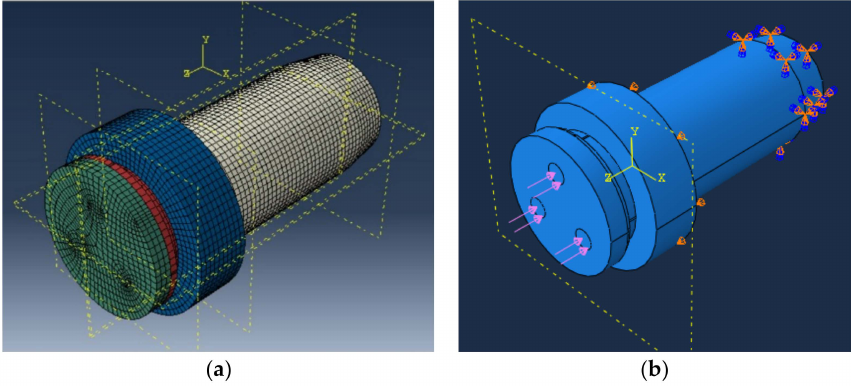
Figure 3. EPS model in Abaqus/CAE. ( a ) Mesh model ( b ) Boundary